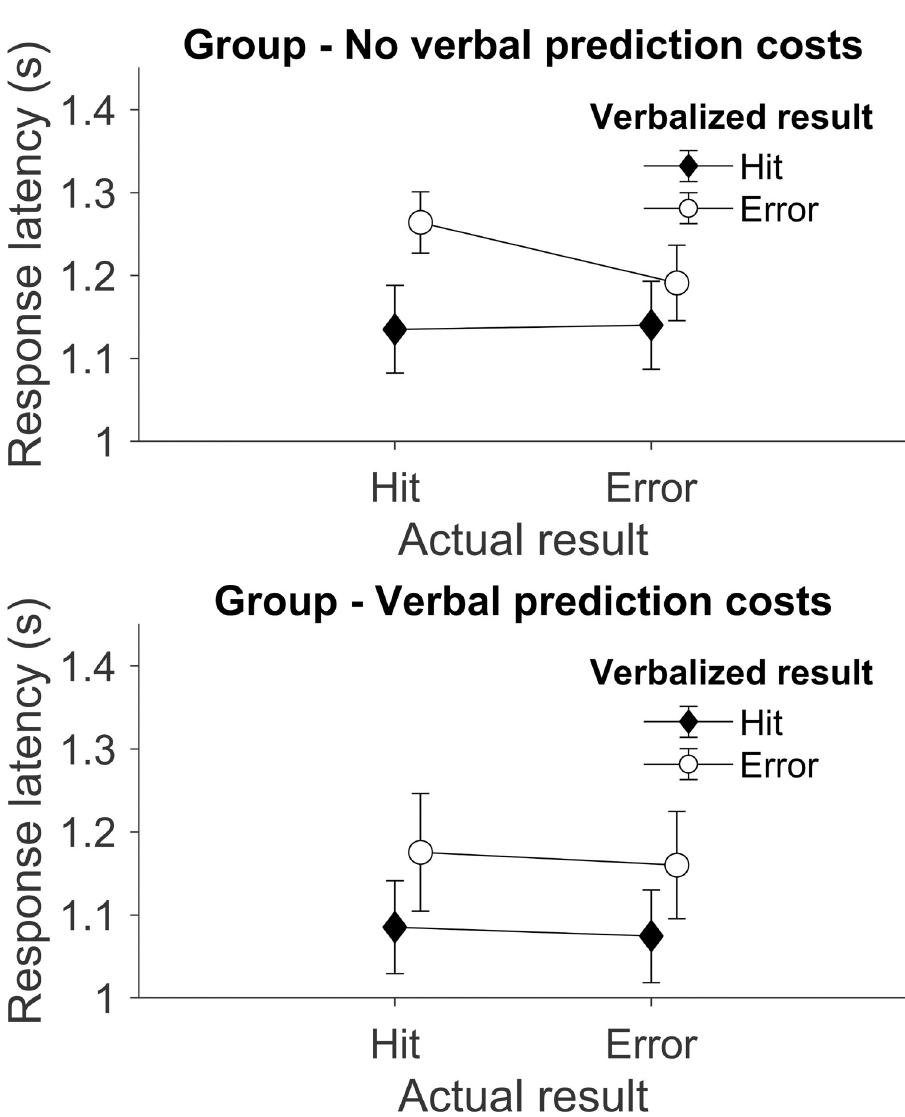
Fig 5. Different response latency effects depending on verbal prediction costs. Average response latencies differentiated after actual results of trials and verbalized results for two groups separated based on whether they experienced verbal prediction costs (bottom) or not (top). Error bars represent standard errors of the